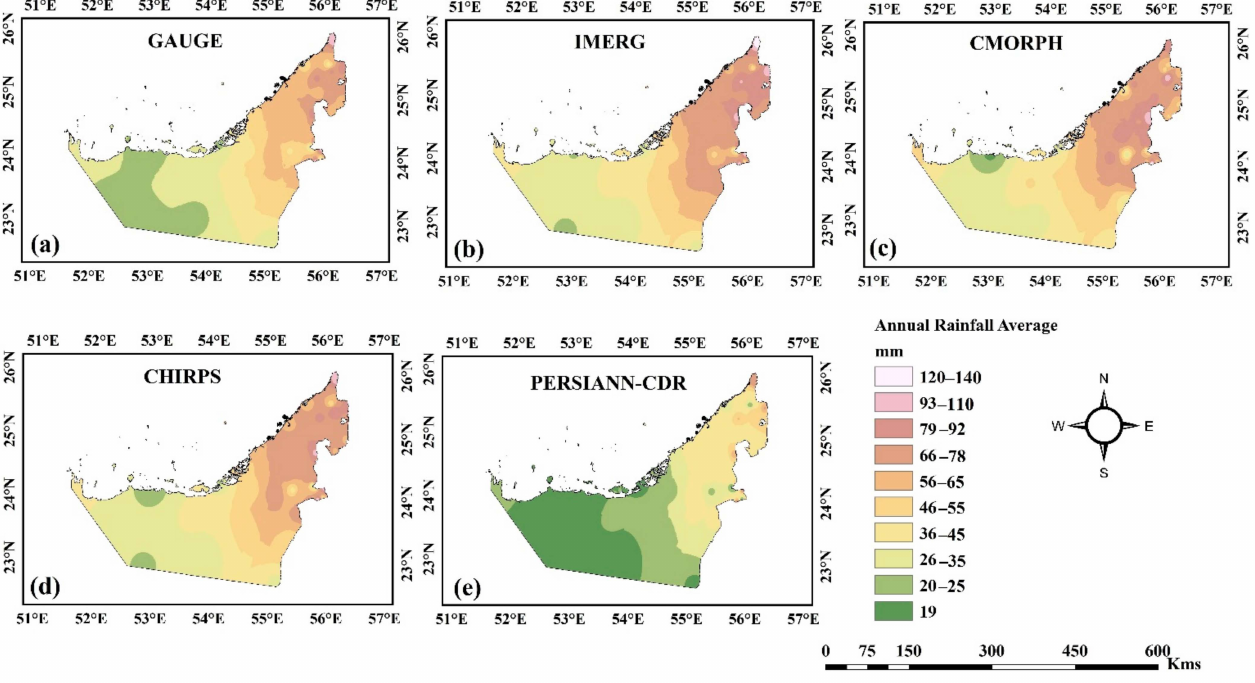
Figure 3. Annual average rainfall distribution for gauge ( a ) and satellite products ( b – e